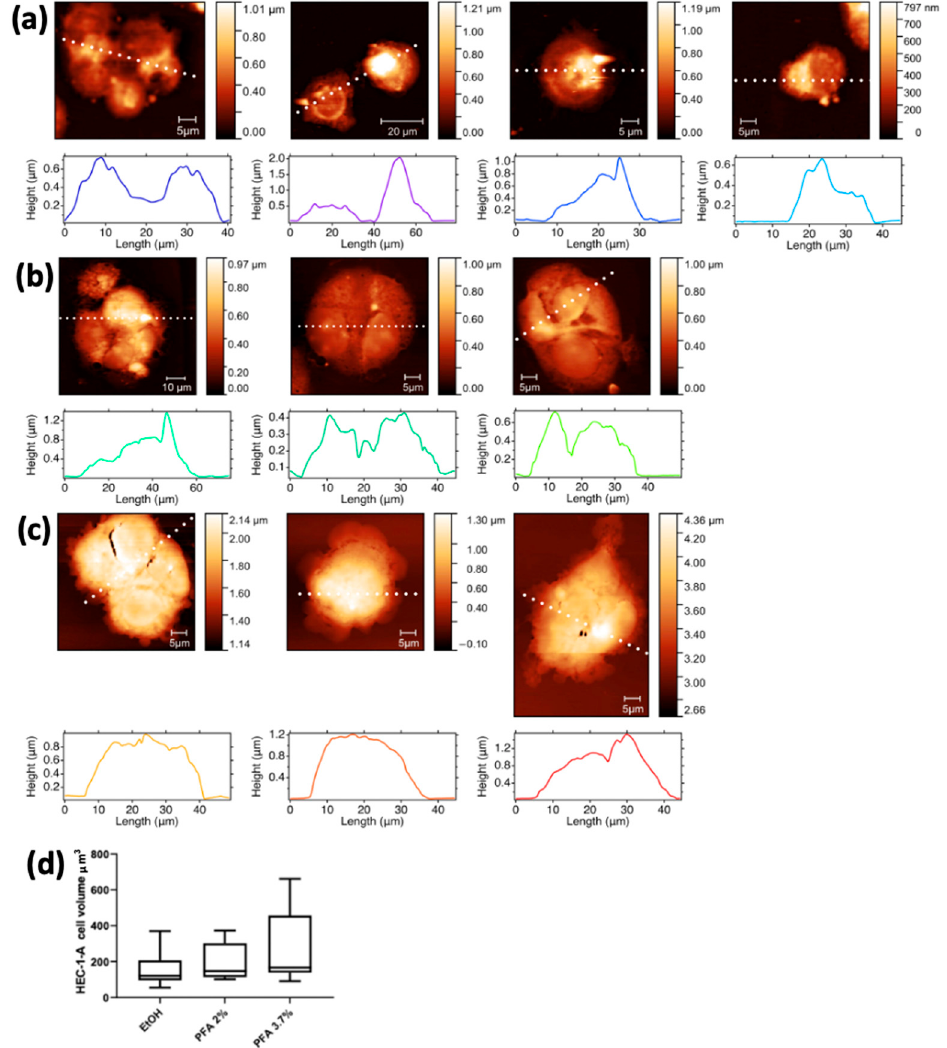
Figure 3. AFM images with corresponding surface profiles of the HEC-1A endometrial cells. The first column shows the same cells depicted in Figure 2, fixed with different methods: ( a ) EtOH, ( b ) PFA 2%, and ( c ) PFA 3.7%. The other pictures of panels a-c show additional cells prepared with the same three fixation methods. ( d ) Min-to-max box plot of HEC-1-A cell volume ( μ m 3 ). Cells in PFA 3.7% have a higher mean volume (264.1 ± 212.3) overall compared to PFA 2% (196.0 ± 104.8) and EtOH 70% (163.3 ± 104.8); although the three values are comparable within their uncertainties, there is a progressive reduction of the cell volume from PFA 3.7% to EtOH.